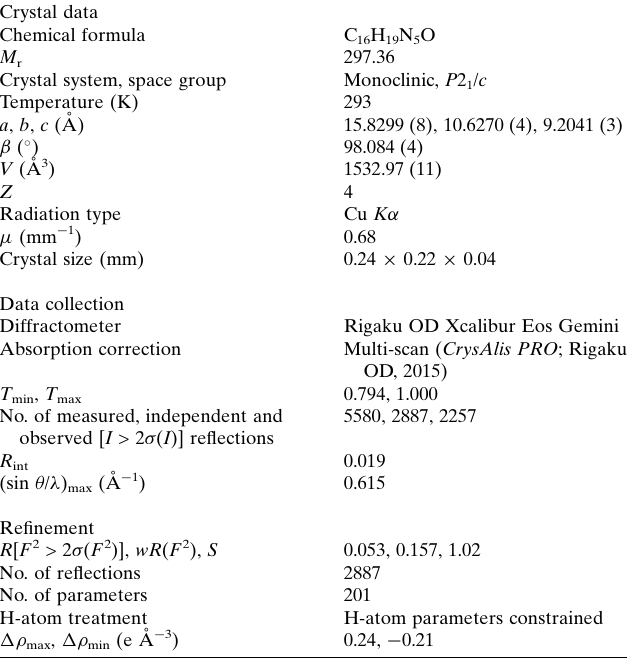
Table 2 Experimental details.